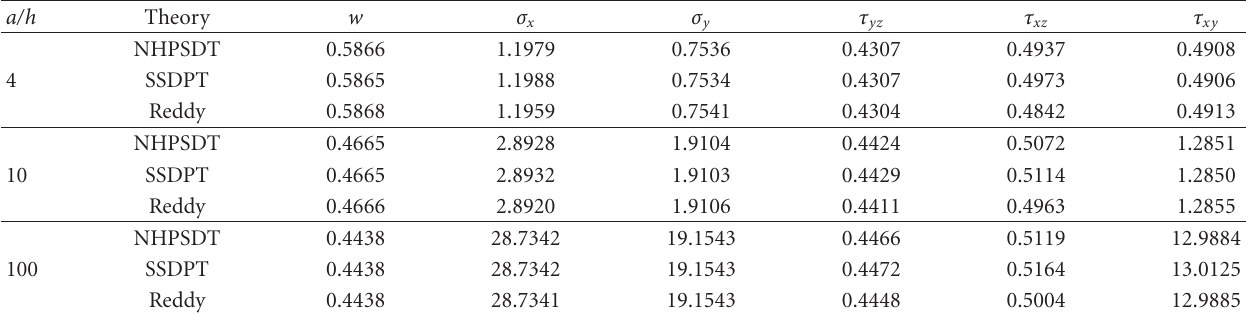
Table 5: Comparison of normalized displacements and stresses of a FGM square plate ( a/b = 1) and k = 0.